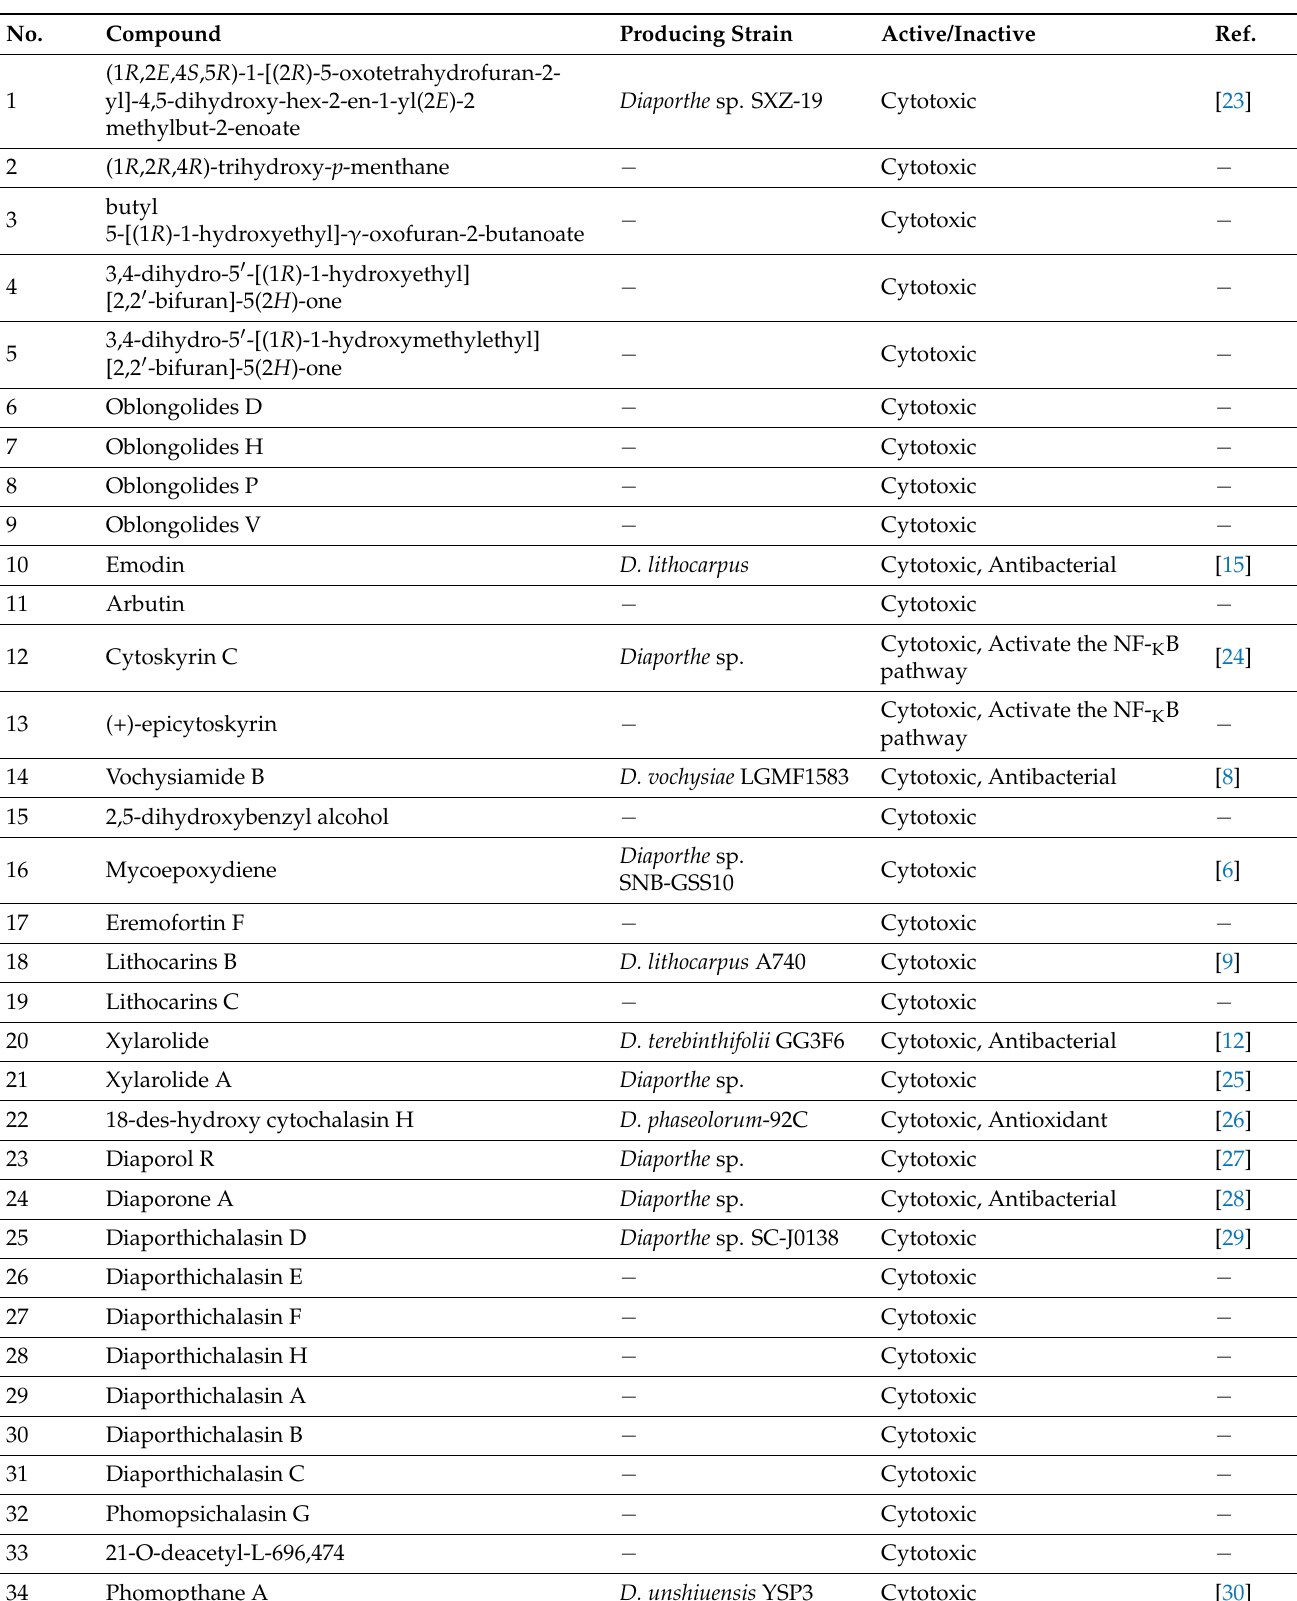
Table 1. Secondary metabolites associated with terrestrial